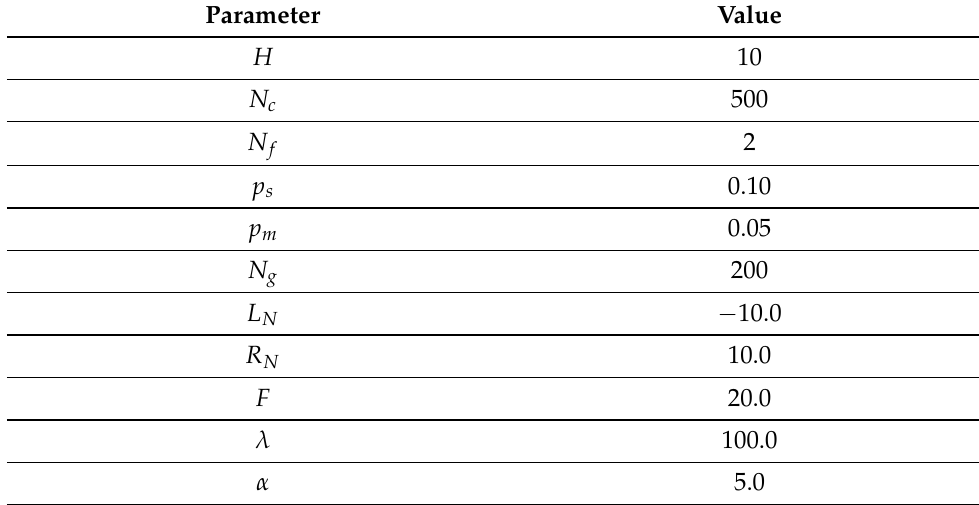
Table 2. Experimental